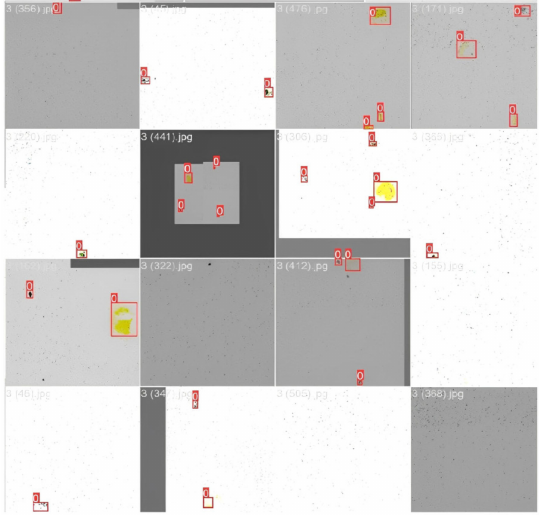
Figure 1. Mosaic data